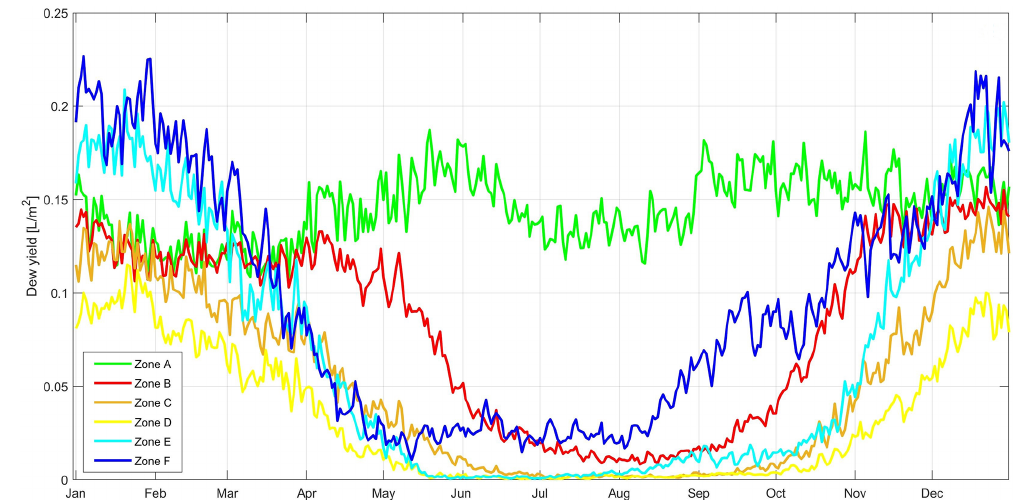
Figure 6. Long-term mean seasonal variation of the cumulative daily dew yield. Note that color coding on this figure is the same and corresponds to the dew formation zones in Fig. 5: dew zone A (Caspian Sea; green), Zone B (Zagros region; red), Zone C (Central Iran; orange), Zone D (Lut Desert; yellow), Persian Gulf zone (light blue), and Oman Sea zone (dark blue). The percentiles (i.e., 25%, median, 75% and 99%) of the daily dew yields as averages for each cluster are presented in Table 4. Table 4. Dew formation zones and their climate features (i.e., mean (min–max) values for meteorological parameters ( T , T d , RH)) as well as statistical analysis for overall mean daily cumulative dew yield (i.e., SD, 25, 50, 75th and 99th percentile as daily max as well as yearly max dew